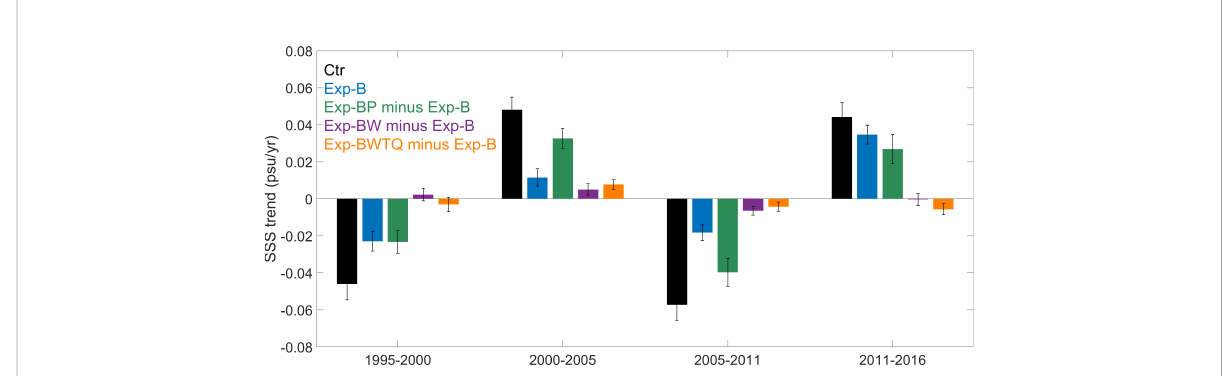
FIGURE 5 Linear trends of SSS in the SEIO for the periods of 1995-2000, 2000-2005, 2005-2011, and 2011-2016 derived from Ctr (black), Exp-B (blue), Exp-BP minus Exp-B (green) and Exp-BW minus Exp-B (purple), and Exp-BWTQ minus Exp-B (orange). Error-bars denote the 90% con fi dence interval based on an F